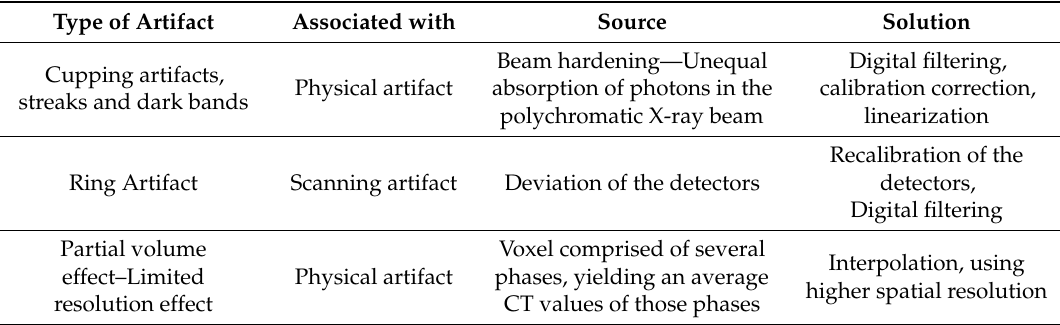
Table 1. Summary of artifacts that occur with an industrial µ CT